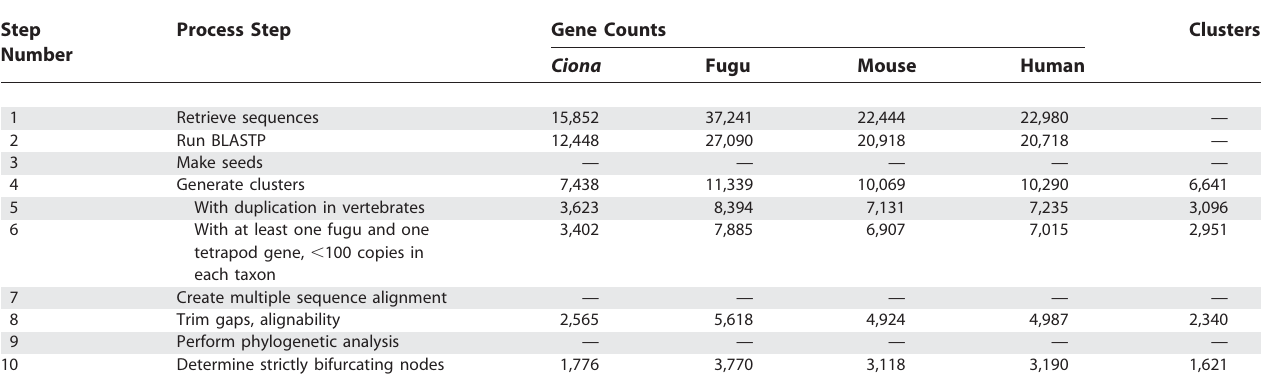
Table 1. Overview of the Process for Analyzing the Complete Gene Sets with Number of Genes Included at Each